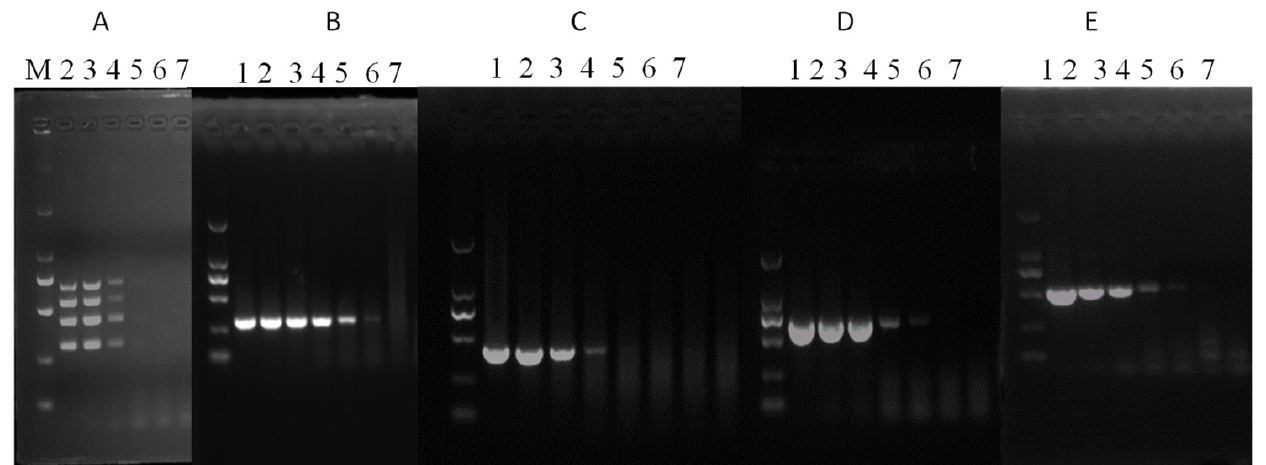
Figure 2. mRT-PCR assay sensitivity. The sensitivity of mRT-PCR and sRT-PCR assays was checked using 10-fold serially diluted plasmids containing SaV, EMCV, RVA and AstV fragments as a tem- plate. M: DL2000 DNA Marker, 1: 2.5 × 10 6 copies, 2: 2.5 × 10 5 copies, 3: 2.5 × 10 4 copies, 4: 2.5 × 10 3 copies, 5: 2.5 × 10 2 copies, 6: 2.5 × 10 1 copies and 7: 2.5 × 10 0 copies. ( A ) mRT-PCR, ( B ) SaV, ( C ) EMCV, ( D ) RVA, and ( E ) AstV.